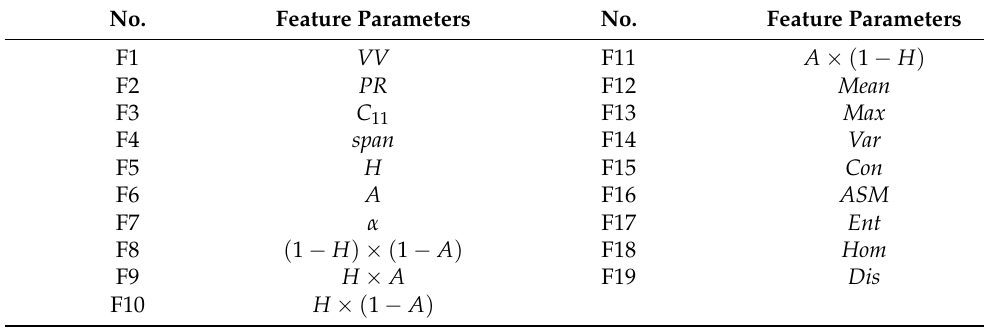
Table 1. Oil Spill Detection Feature